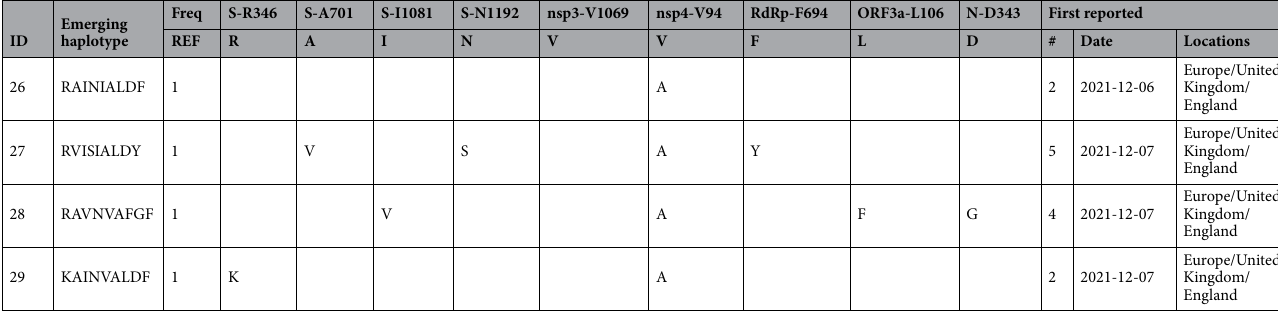
Table 3. Haplotype analysis of 9 emerging mutations in Omicron viruses; haplotype frequencies, changes of individual amino acids from the reference, number of observed mutations in the haplotype, date and location of the first report. Note that all haplotypes are sorted by time and location of the first report. The reference haplotype is highlighted in red font. # Number of mutations observed on the polymutant